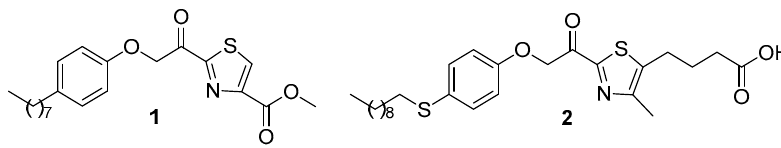
Figure 2. Examples of α -ketothiazoles exhibiting anti-inflammatory properties.